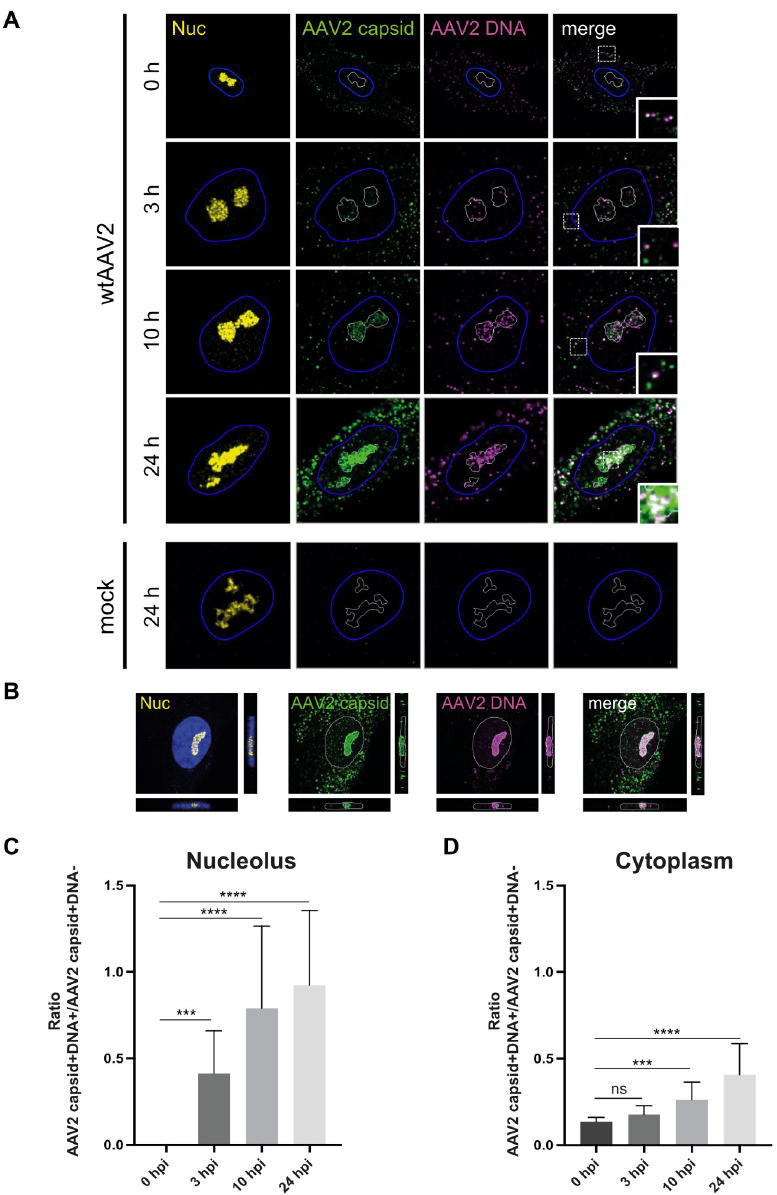
Fig 1. Spatial distribution of AAV2 capsids and DNA over time. NHF cells were infected with wtAAV2 (MOI 20‘000). At various time points post infection, the cells were fixed and processed for multicolor IF analysis combined with FISH and CLSM. Nucleoli (Nuc) were visualized using an antibody against fibrillarin (yellow). Intact capsids were stained using an antibody that detects a conformational capsid epitope (green). AAV2 DNA (magenta) was detected with an Alexa Fluor (AF) 647 labeled, amine-modified DNA probe that binds to the AAV2 genome. (A) Spatial and temporal distribution of AAV2 capsids and DNA. The white line represents the edge of the nucleoli (fibrillarin staining), the blue line represents the edge of the nucleus (4‘,6-diamidino-2-phenylindole (DAPI) staining). (B) Orthogonal projections of a z-stack at 24 hpi. The white line represents the edge of the nucleus (DAPI staining). (C) Image-based quantification of the uncoating rate of 50 individual cells per time point in the nucleolus and (D) in the cytoplasm. p-values were calculated using an unpaired Student‘s t-test ( � —p � 0.05, �� —p � 0.01, ��� —p � 0.001, ���� —p �